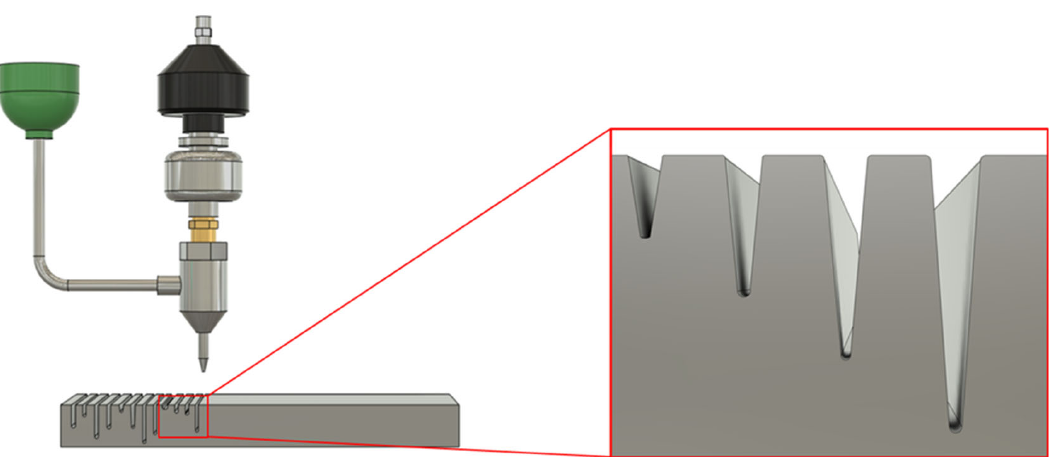
Figure 1. Graphical representation of the AWJM process and the influence of the process parameters on the slot’s geometry.